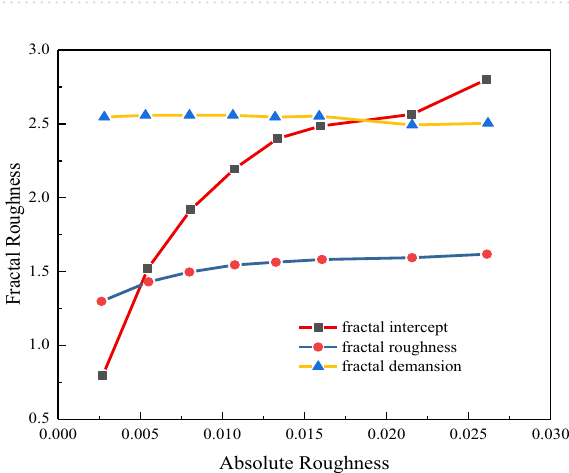
Table 1. Fractal roughness.